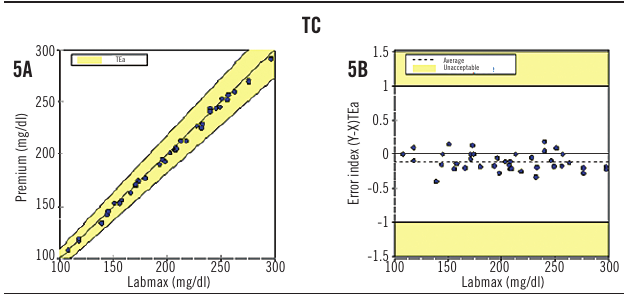
figurE 5 − Comparisons between TC measurement for 2 automated chemistry platforms A) linear regression for TC measurements between instruments Labmax 240 ® (E1) and Labmax 240 Premium ® (E2): n = 40, r = 0.998, p < 0.05; equation for the correlation: E2 = 0.981*E1 + 1.7; TEa = 9%; B) graph comparing the systems Labmax 240 ® (E1) and Labmax 240 Premium ® (E2) for TC measurement: error index = [(result - mean)/TEa] (table of biological variation); results > +1 and < -1 are considered inadequate ( n = 40).